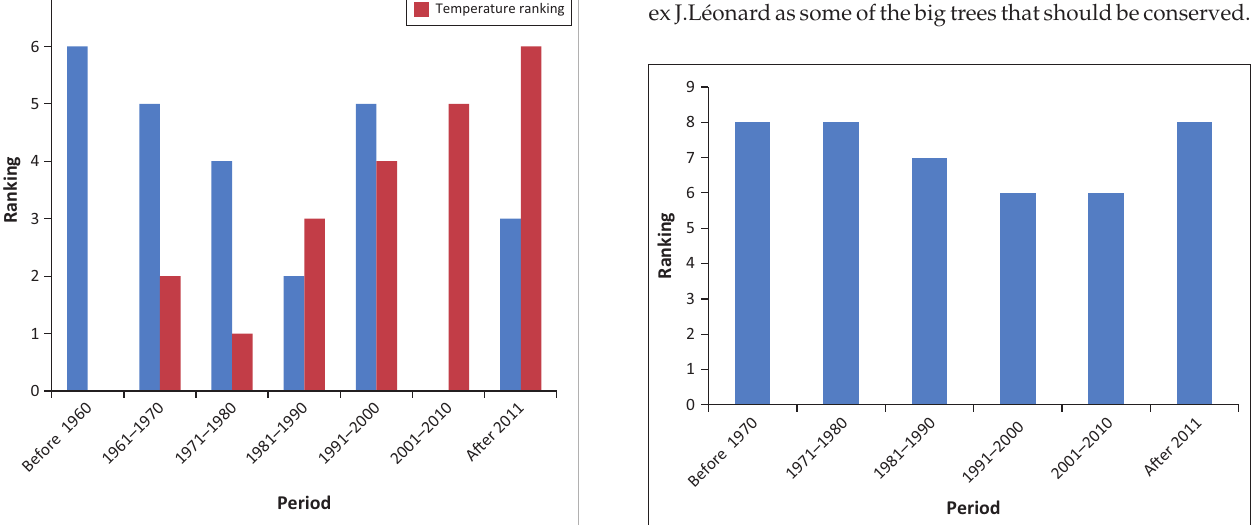
FIGURE 4: Perceived malaria trends 1970–2014: ward 11.